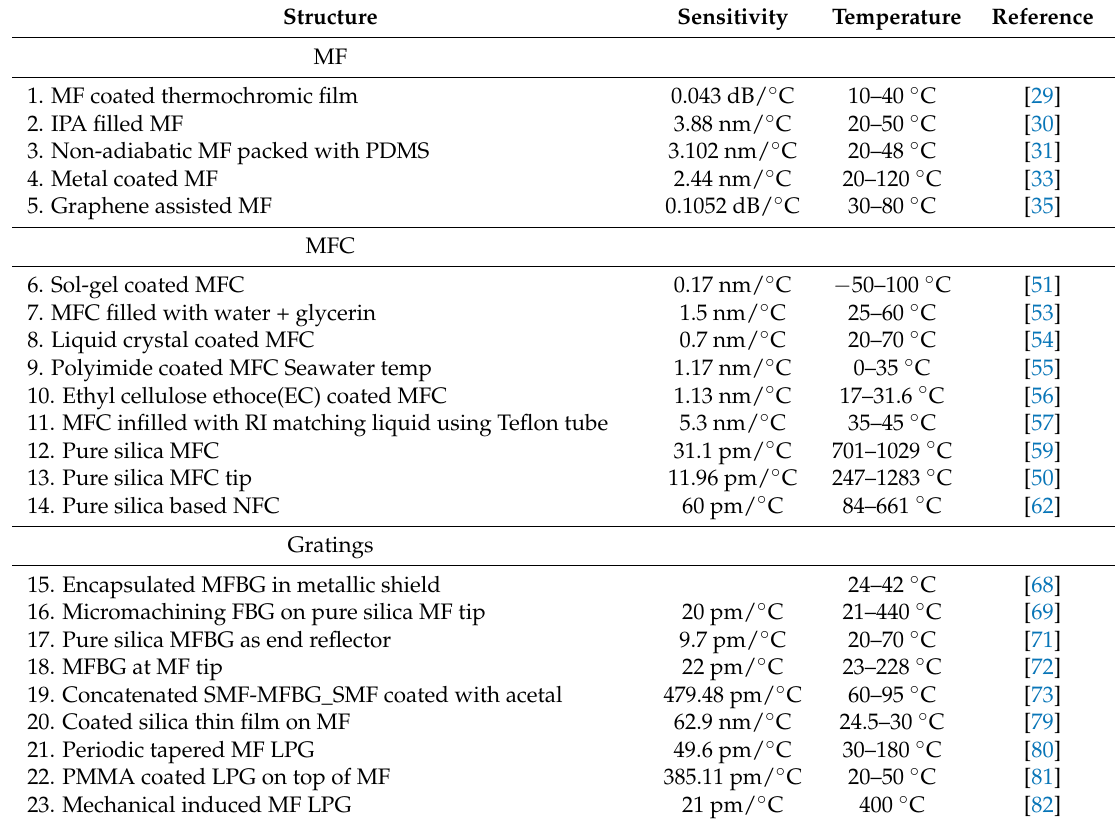
Table 1. Summary of MF